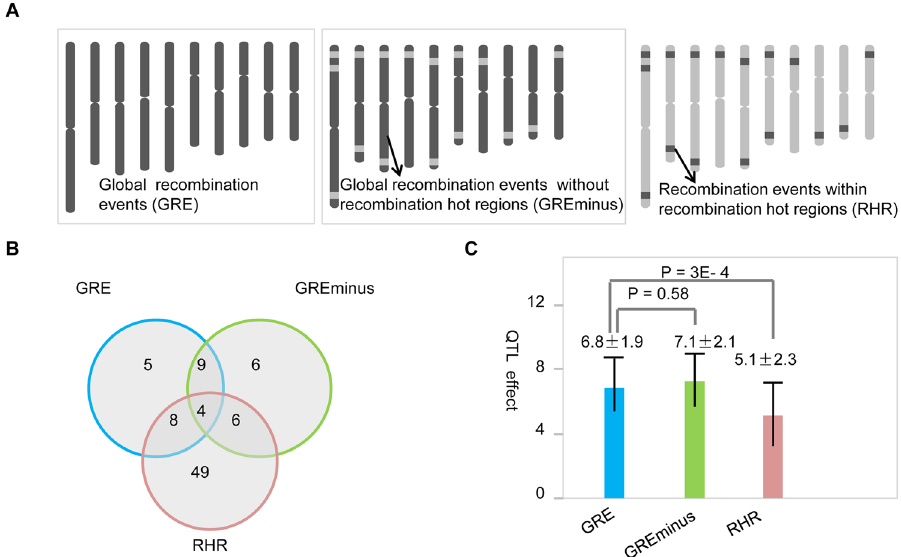
Figure 1. QTL mapping of recombination number variation in maize. ( A ) The schematic diagram of global recombination events (GRE, left panel), global recombination events substracting recombination number in recombination hot regions (GREminus, middle panel), and recombination event in recombination hot regions (RHR, right panel). Recombination number from dark genomic regions was counted for QTL mapping, while the ones from grey regions were excluded. ( B ) Venn Diagram of QTL mapping results among GRE, GREminus and RHR. ( C ) QTL effect variation among GRE, GREminus and